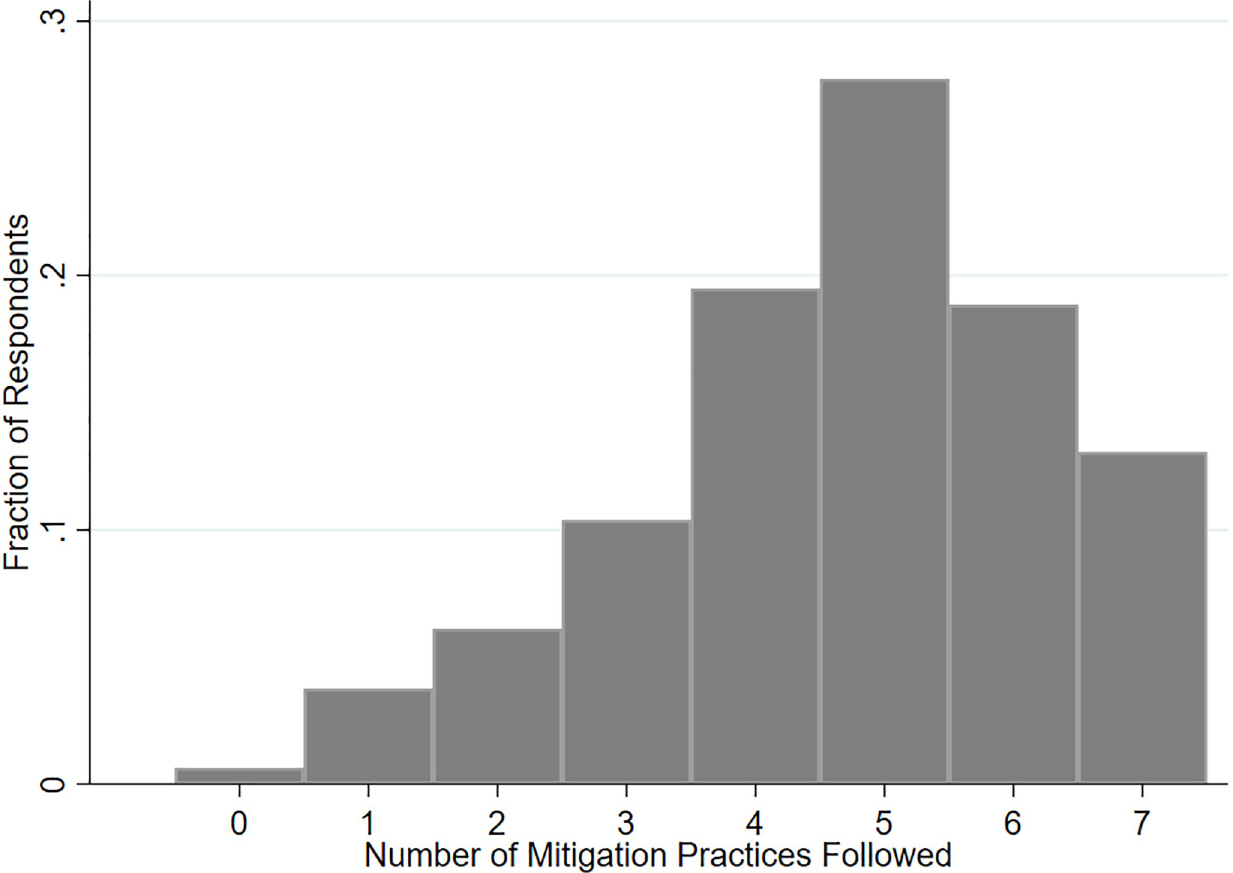
Fig 4. Histogram of the number of mitigation strategies practiced by different households. The number of mitigation practices followed by each respondent was calculated and the fraction who are following different numbers of practices is plotted in this histogram.